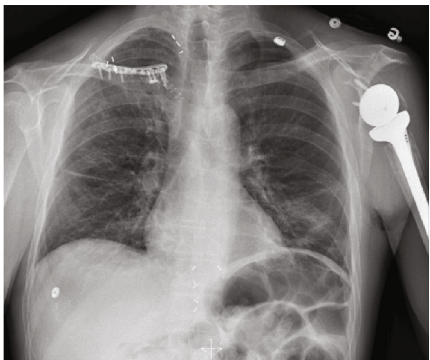
Figure 3: Postoperative chest radiograph following the open reduction and osteosynthesis procedure. The fracture was fi xed using an inverted anatomic locking plate.